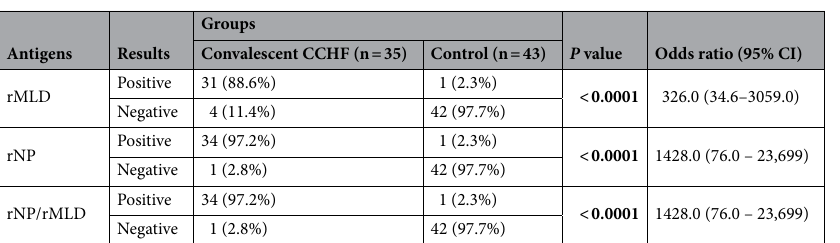
Table 2. Comparison of test results for the Rec-ELISA using rNP, rMLD, and rNP/rMLD probed with sera of convalescent phase CCHF patients (n: 35). CI confidence interval. Bold values are statistically significant for P